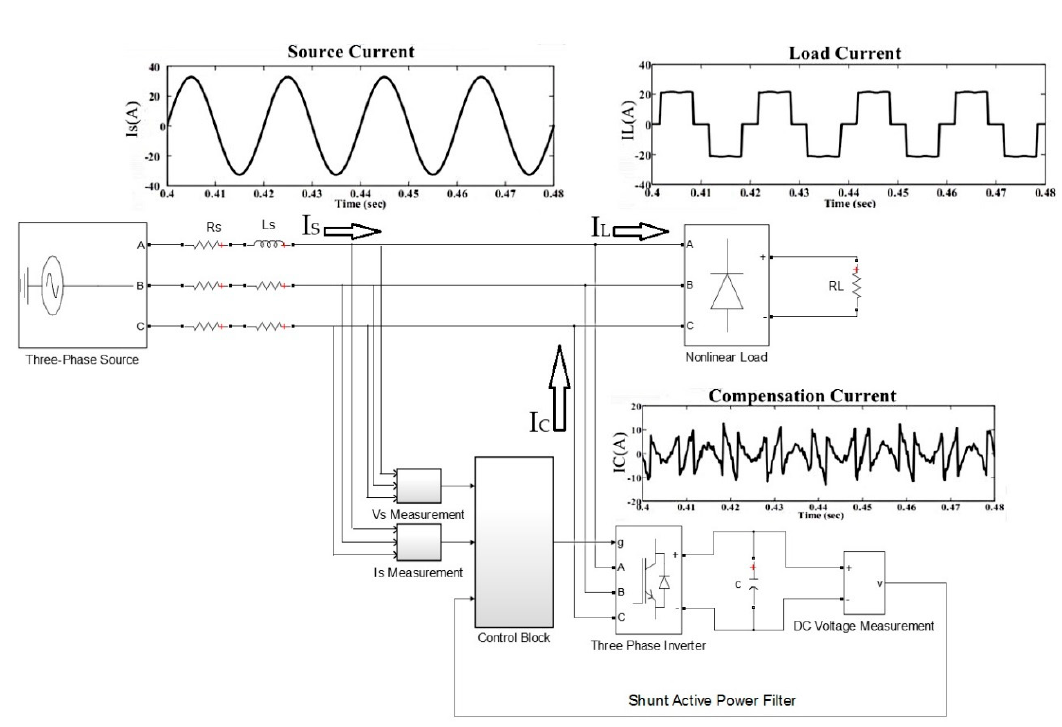
Figure 1. Three-phase three-wire shunt active power filter configuration.